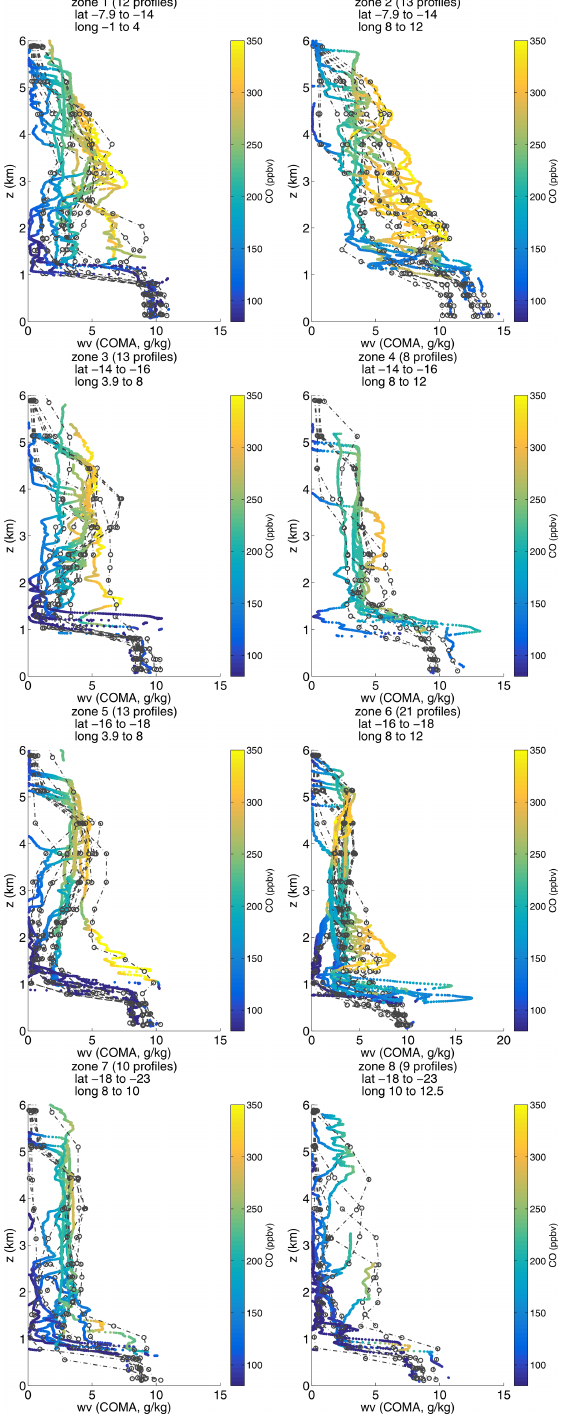
Figure 8. Profiles of specific water vapor measured by COMA in ORACLES-2016 (solid lines), subdivided by spatial location. Col- ors indicate the CO concentration from COMA. Dash-dotted lines show spatiotemporally co-located ERA5 reanalysis profiles for each aircraft profile, which captures the variability in vertical structure reasonably